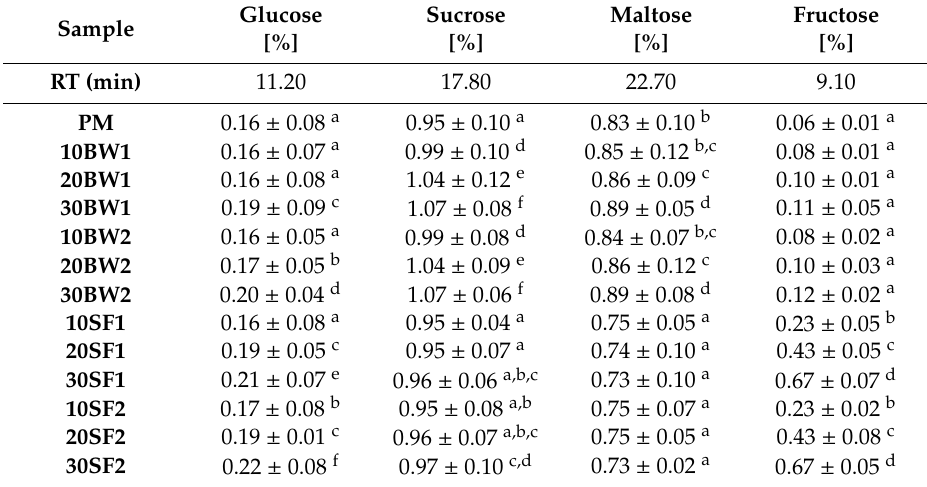
Table 7. Free sugars content from buns.